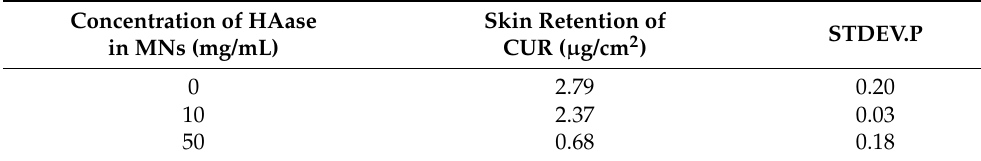
Table 2. Cumulative permeation amount of CUR in MNs.